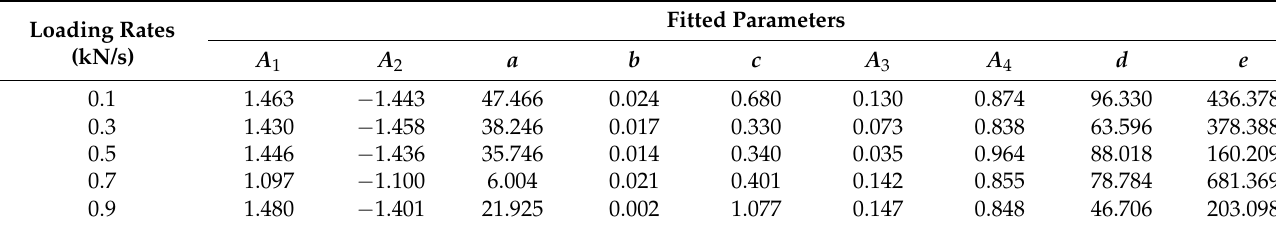
Figure 1 1 . Fitting AE count function diagram. Figure 11. Fitting AE count function diagram. Table 2. Fitted parameters under different loading